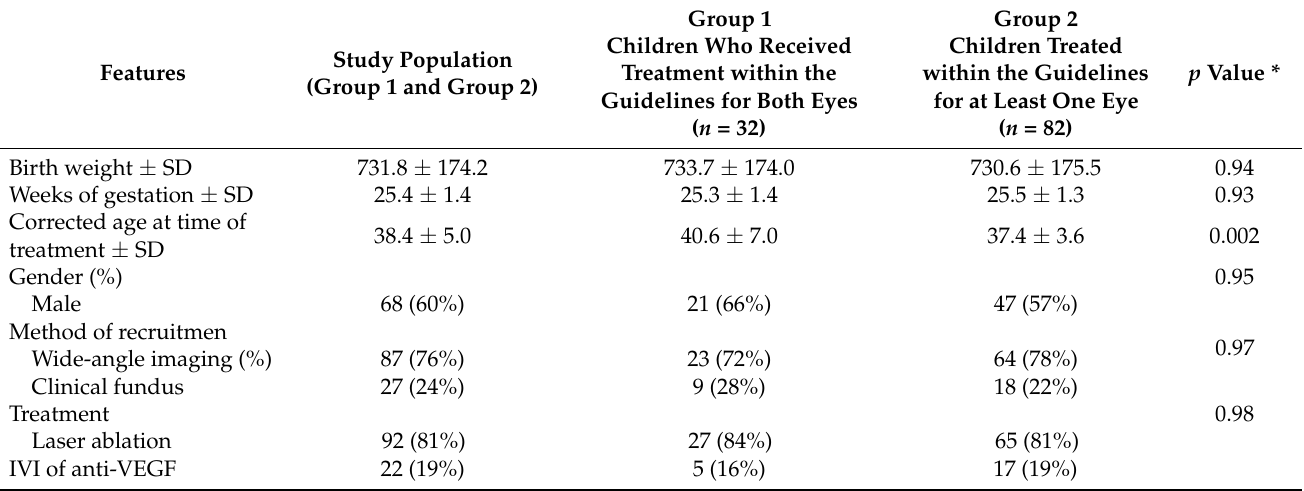
Table 1. Characteristics of the study